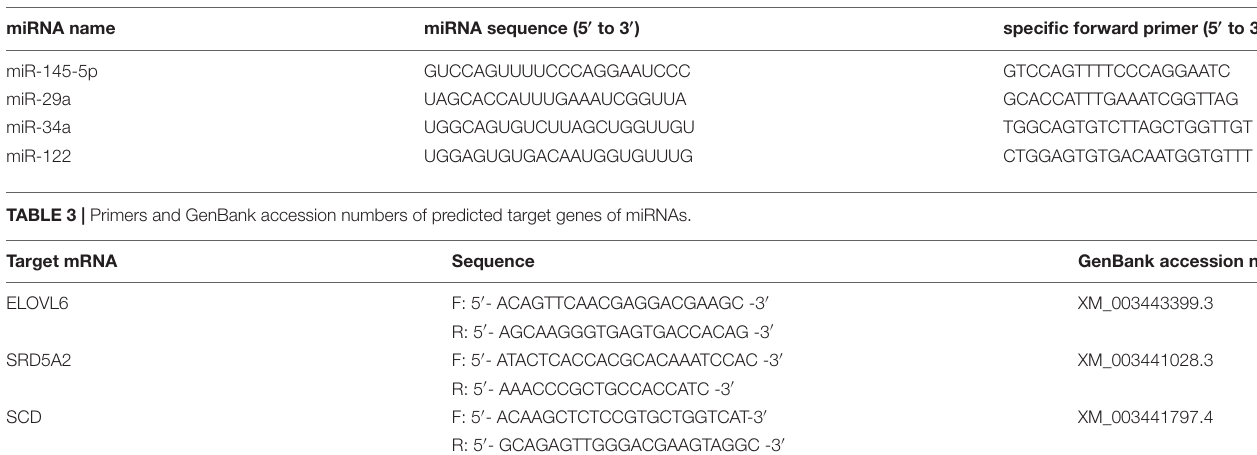
TABLE 2 | miRNA primer sequences.